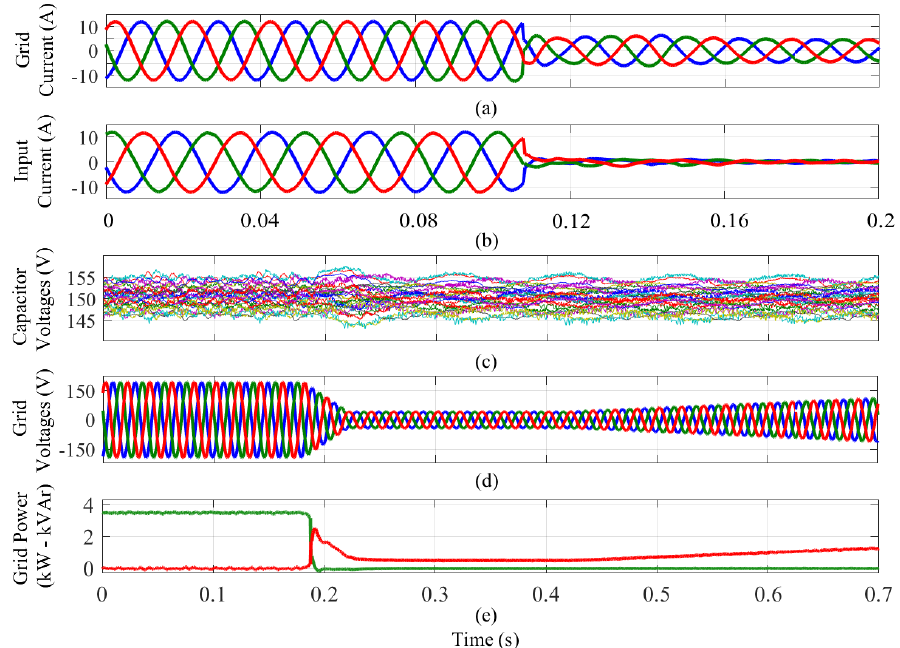
Figure 12. Experimental results obtained for a balanced grid fault. ( a ) Output port currents. ( b ) Input port currents. ( c ) Voltages in the 27 capacitors. ( d ) Grid voltages. ( e ) Active and reactive powers. Adapted from